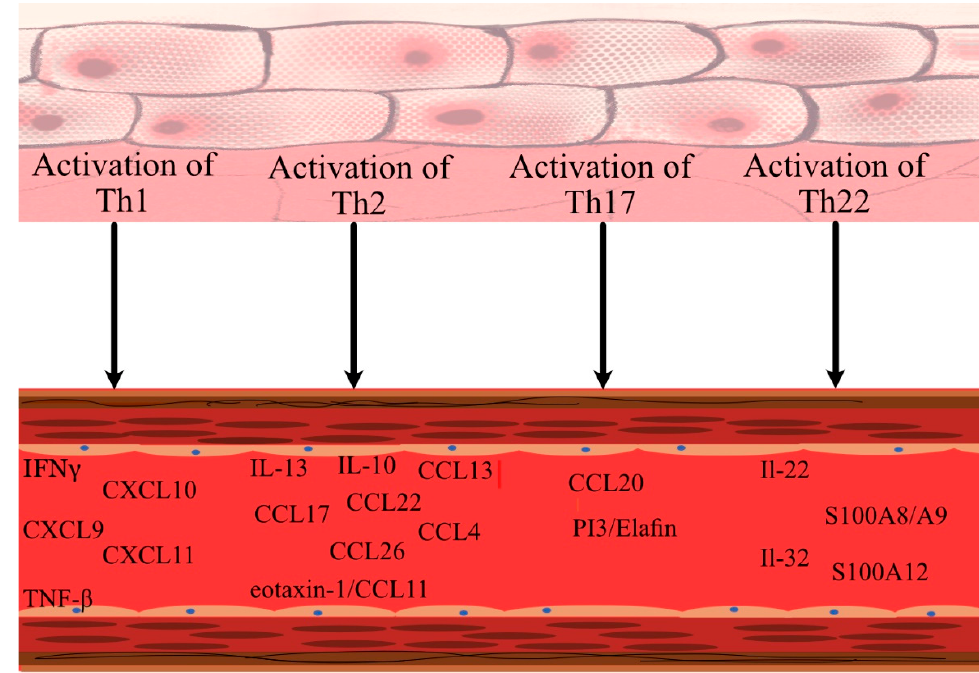
Figure 2. Upon activation of critical T helper (Th) cells involved in the pathogenesis of AD, a number of cardiovascular biomarkers are upregulated. INF- γ —interferon gamma, TNF- β —tumour necrosis factor beta, CXCL—C-X-C motif ligand, Il—interleukin, CCL—C-C motif chemokine ligand, PPi3/elafin—peptidase inhibitor 3/elafin, S100A12—calgranulin C, S100A8/A9 (=MRP8/14)— myeloid-related protein